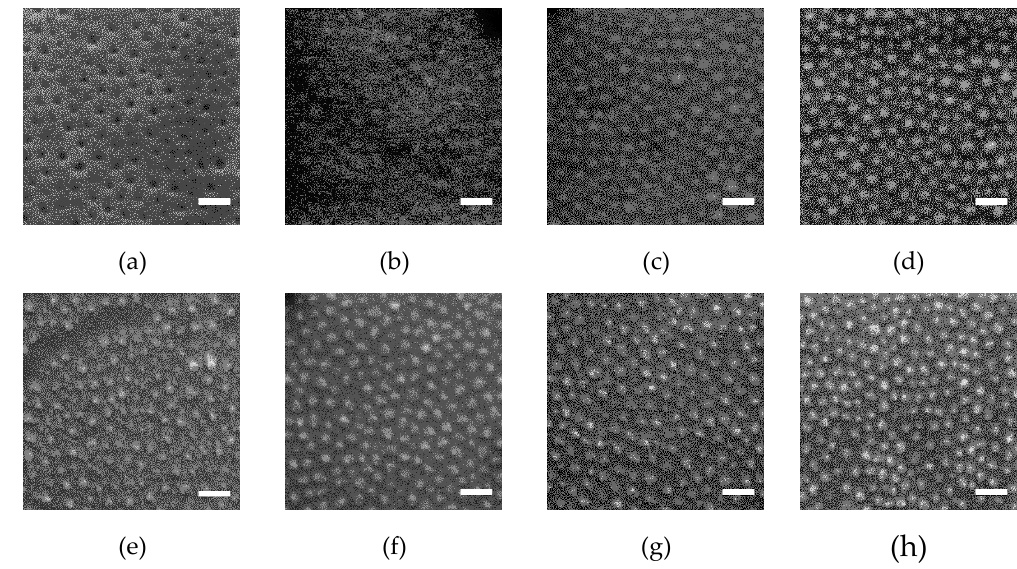
Figure 3. Scanning electron microscopy (SEM) images of the ion-loaded SEO-89k templates after UV / O 3 treatment. The treatment durations are 0 min for ( a ) and ( e ); 10 min for ( b ) and ( f ), 30 min for ( c ) and ( g ); and 60 min for ( d ) and ( h ). Images in the first row are from samples before thermal annealing (TA), and in the second row is after TA. The scale bars are 100 nm.